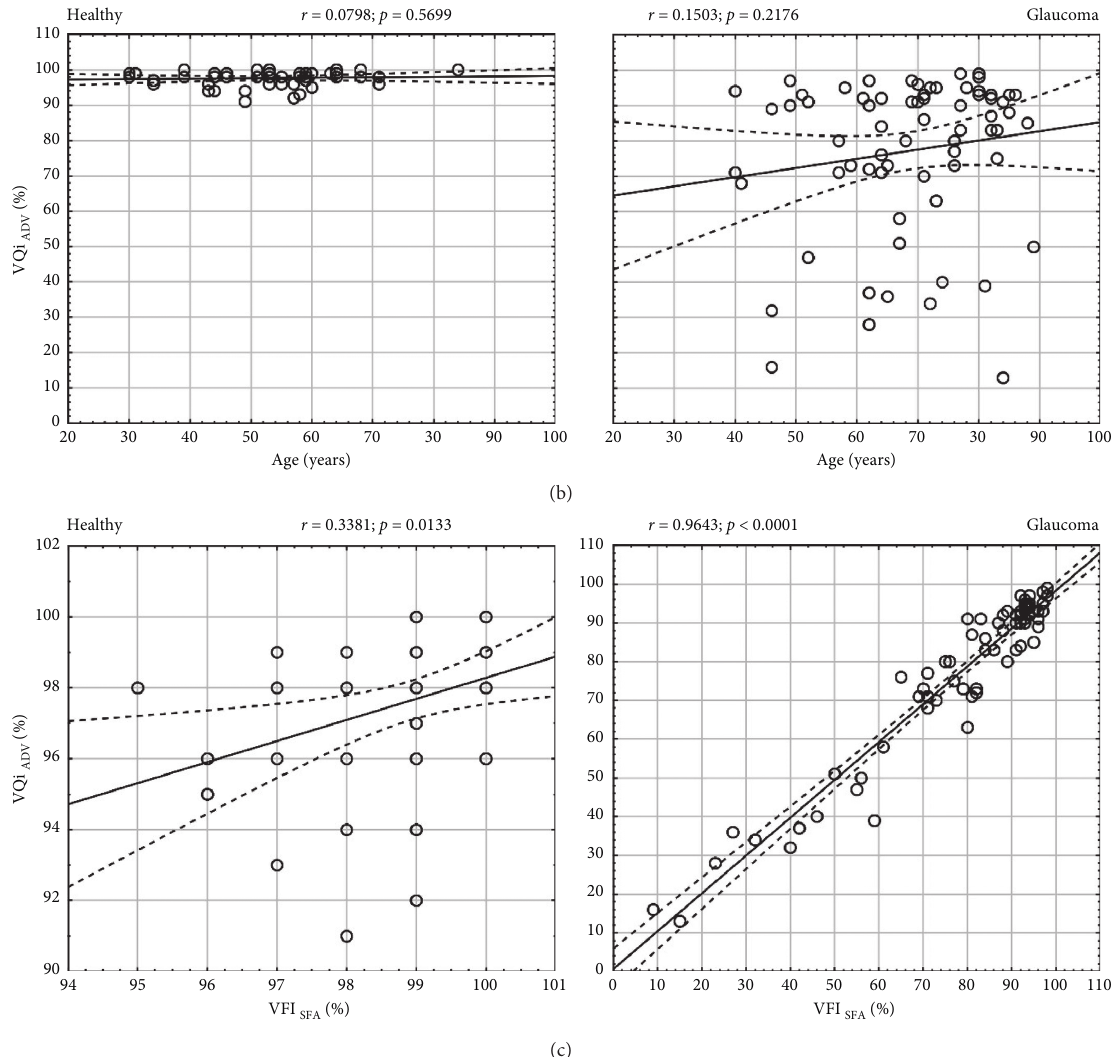
Figure 10: Visual field (VFI) and visual quality (VQi) indices analysis in the healthy and glaucoma group. (a, b) Correlation of VFI (for SFA) and VQi (for ADV) with patient age; (c) correlation between VQi and